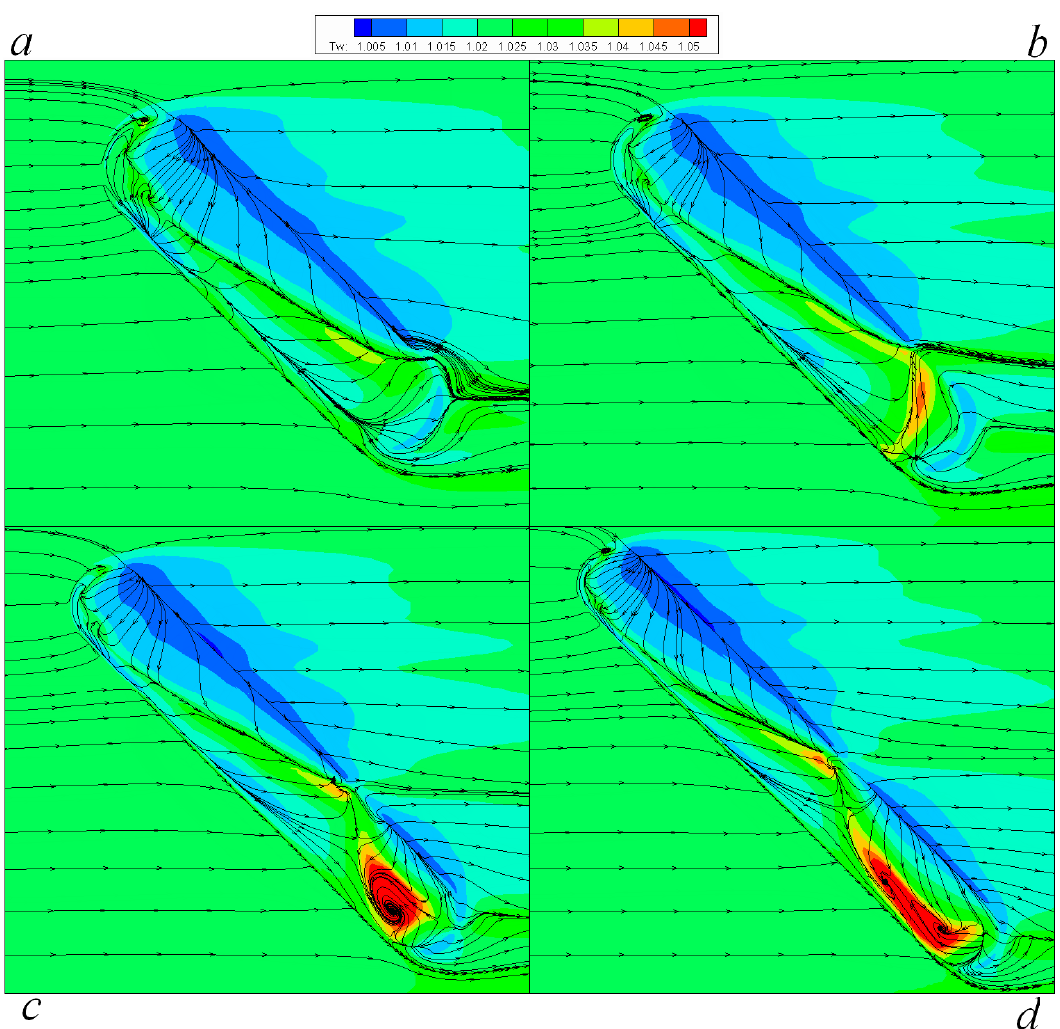
Figure 14. Temperature fields at the heated wall with oval dimples of width 0.482 ( a ), 0.429 ( b ), 0.383 ( c ) and 0.346 ( d ) and the streamlines.